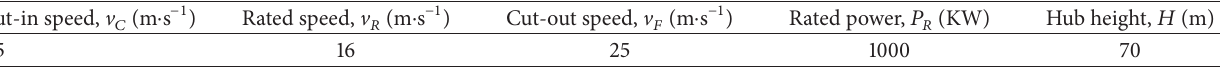
Table 2: NEG Micon 1000/60 fixed speed turbine data.